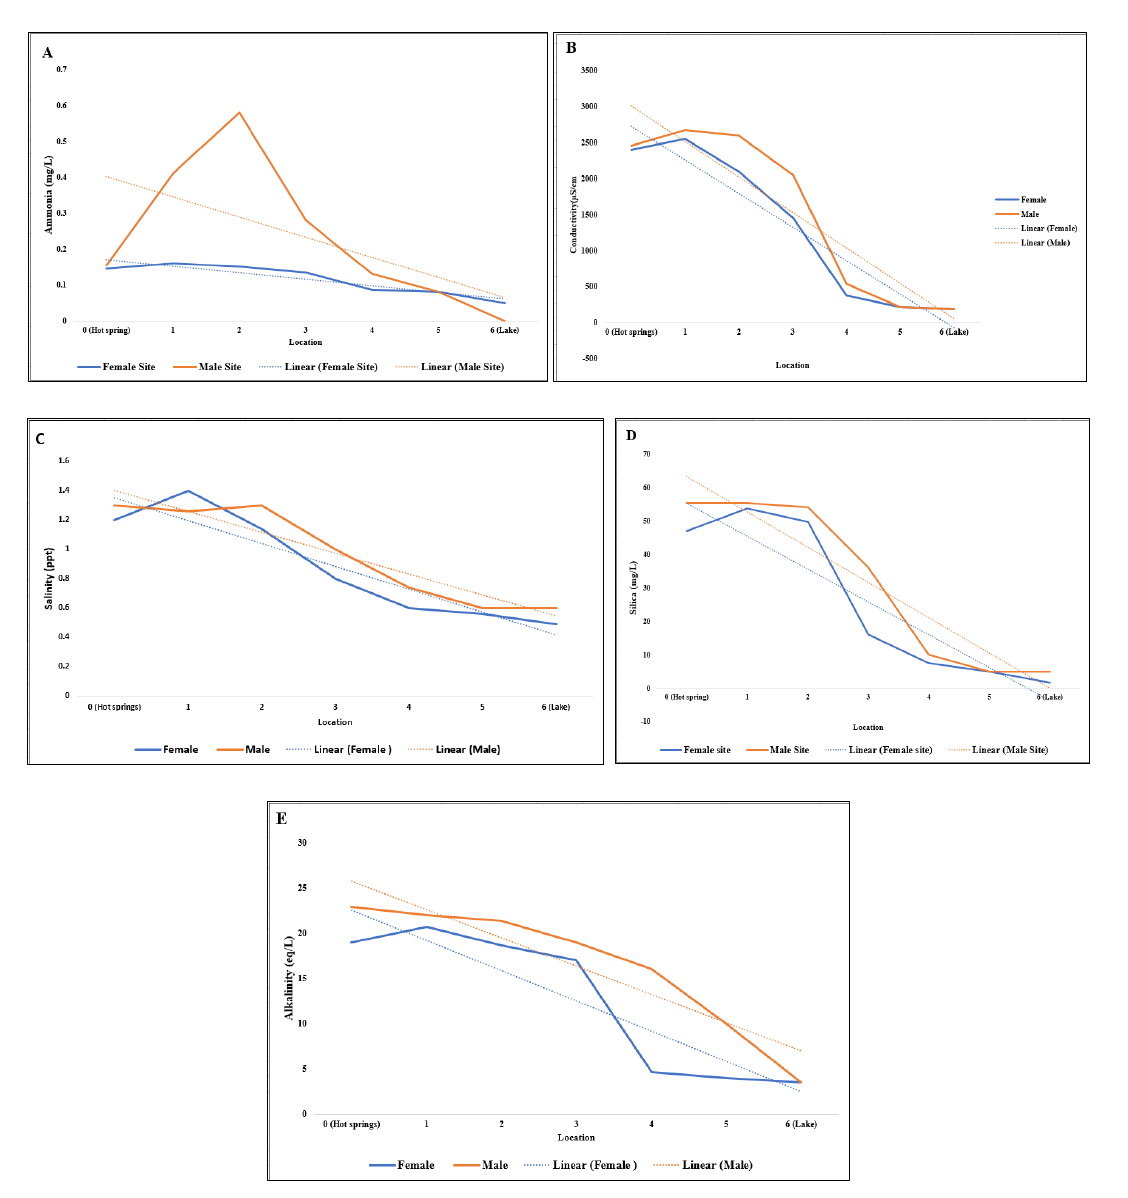
Figure 3. Comparison of chemical composition of water samples taken at seven locations at two sites (female and male). ( A ) ammonia, ( B ) conductivity, ( C ) salinity, ( D ) silica, and ( E ) alkalinity.